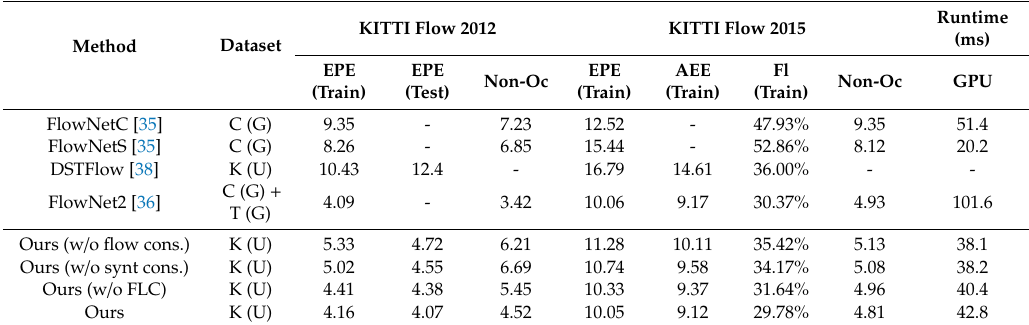
Table 2. Quantitative optical flow comparison result on the KITTI flow 2012 and KITTI flow 2015 datasets. The Flying Chairs dataset [35] is denoted as C, Flying Things dataset [37] as T, and KITTI raw dataset as K. The learning approach (G) is supervised by the ground truth, and (U) represents an unsupervised method. Non-Oc indicates a non-occluded